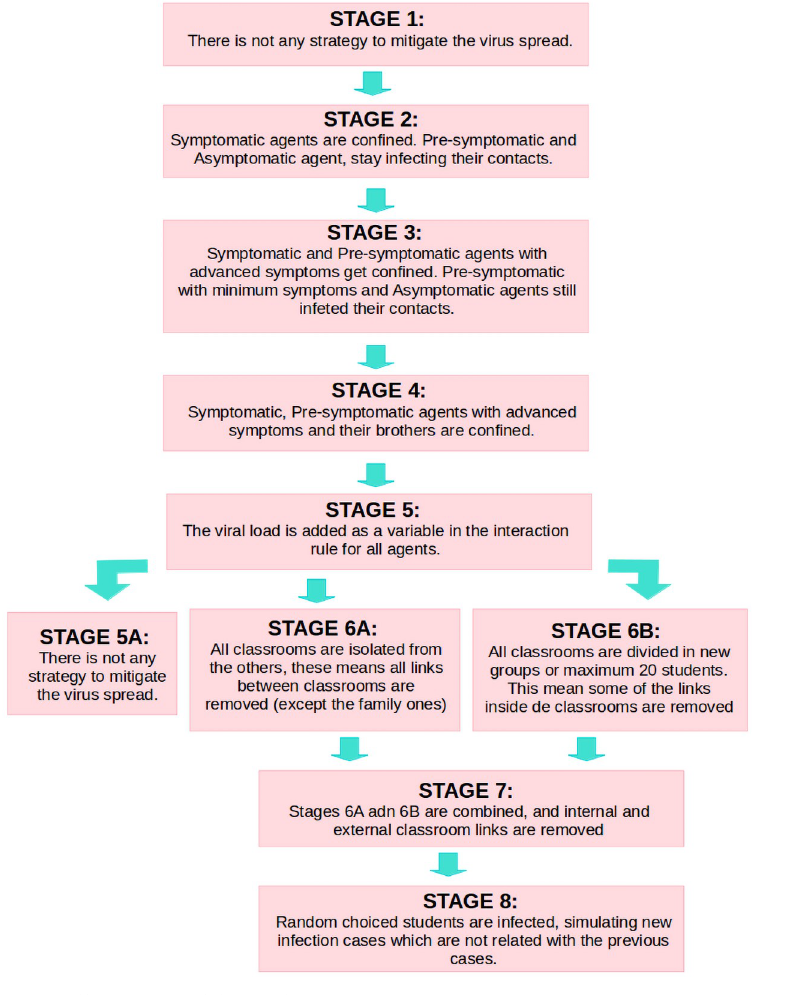
Fig 2. Different stages of the